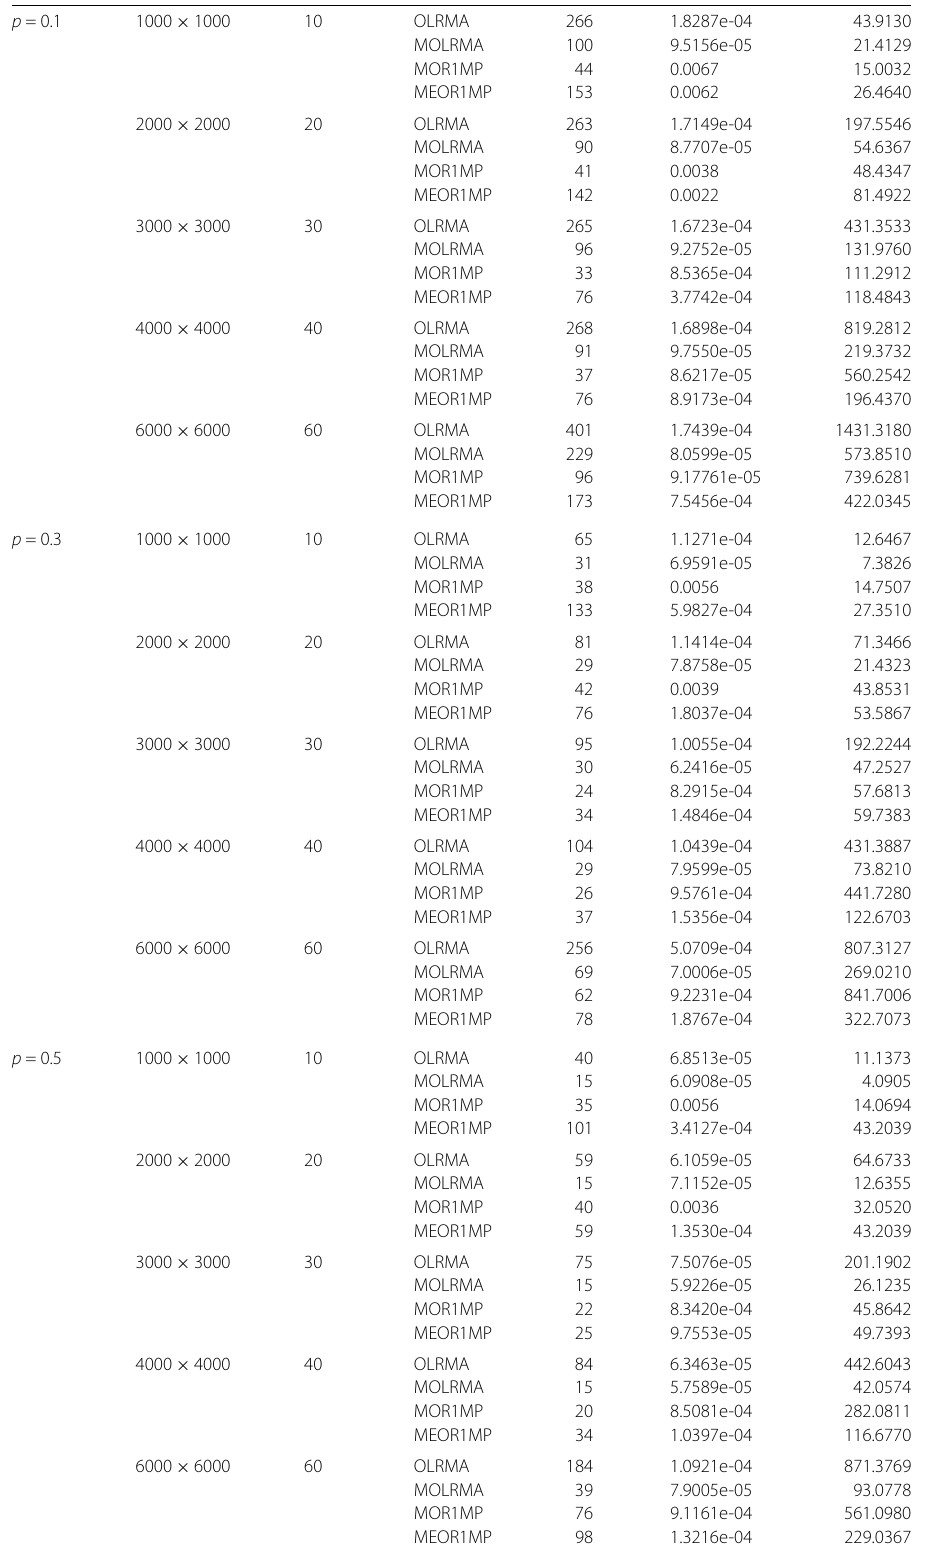
Table 1 Comparison results by the OLRMA, MOLRMA, MOR1MP, and MEOR1MP algorithms Size Rank Algorithm IT Error CPU (s) p = 0.1 1000 × 1000